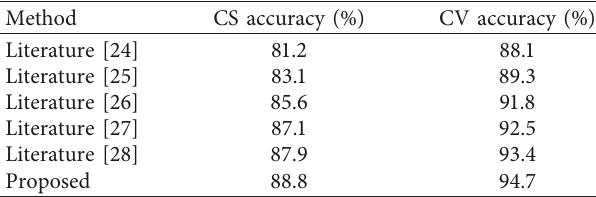
Table 3: Performance comparison of NTU-RGB+D data